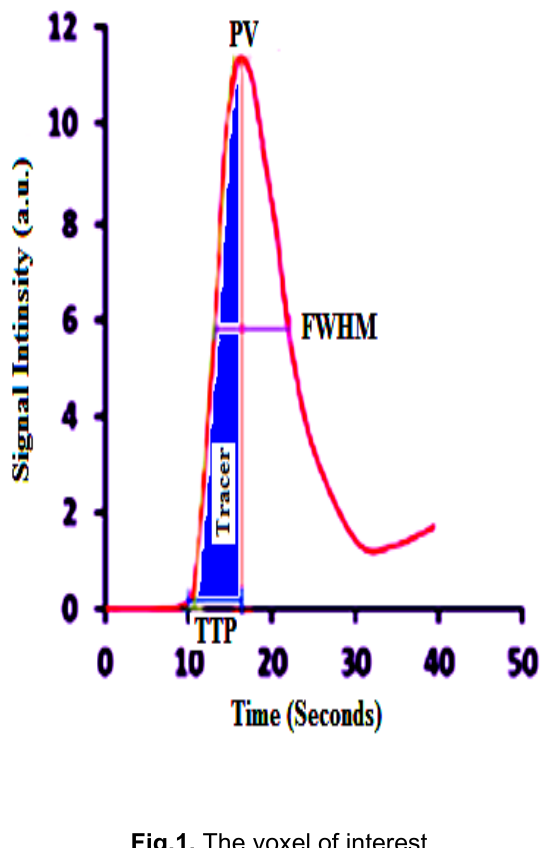
Fig.1. The voxel of interest